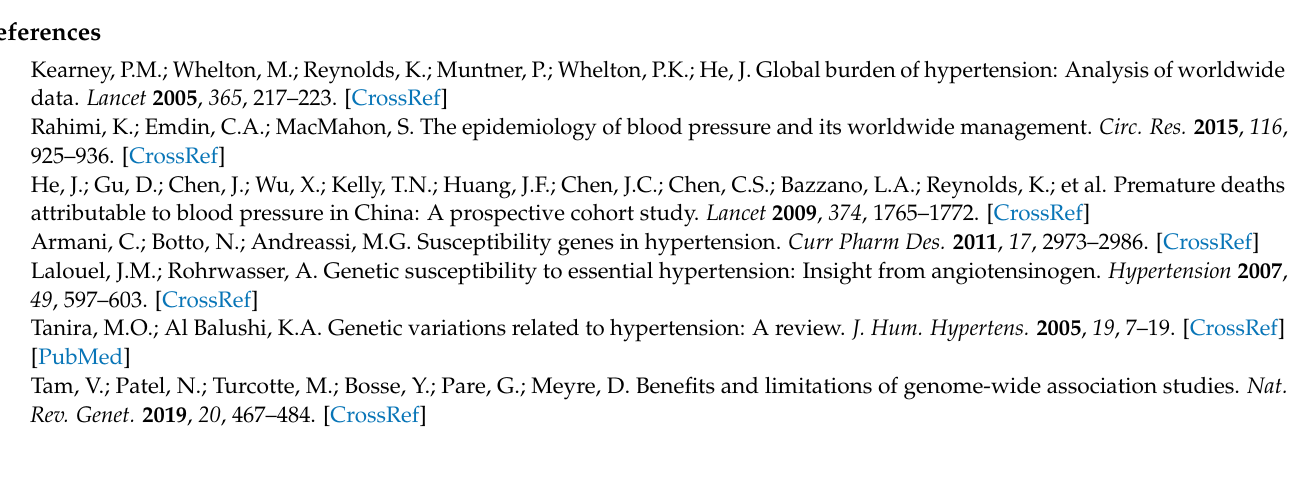
Table S2: Results of functional enrichment tests with KEGG pathway gene sets, Table S3: Variants of INO80 in GWAS catalog